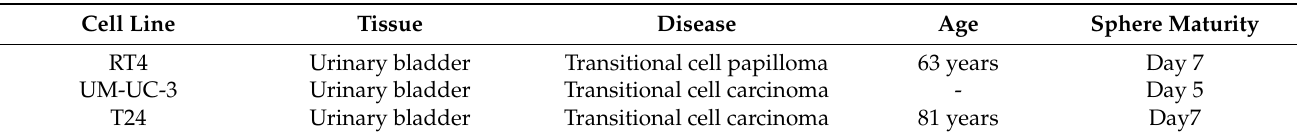
Table 1. Cell lines specifications.